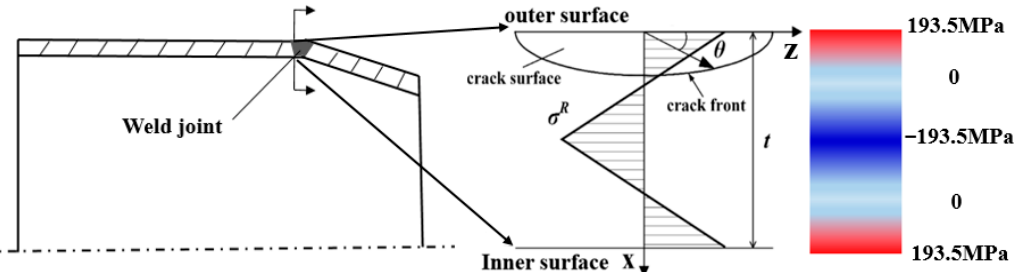
Figure 3. The distribution of residual stresses.